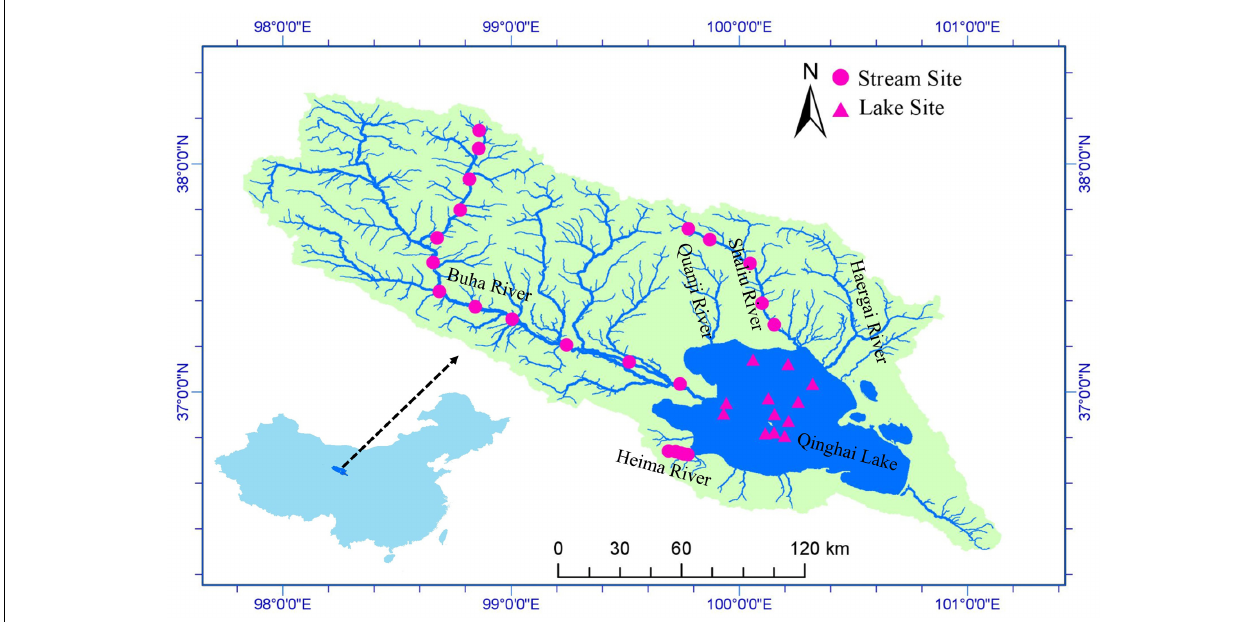
FIGURE 1 | Study area and sample sites. Qinghai Lake is the largest lake in China and located on Qinghai-Tibet Plateau. Water samples and microbial samples were collected at 22 stream sites and 12 lake sites. The map was created in ArcGIS 14.0 (http://desktop.arcgis.com/en/arcmap/) using DEM image download from USGS